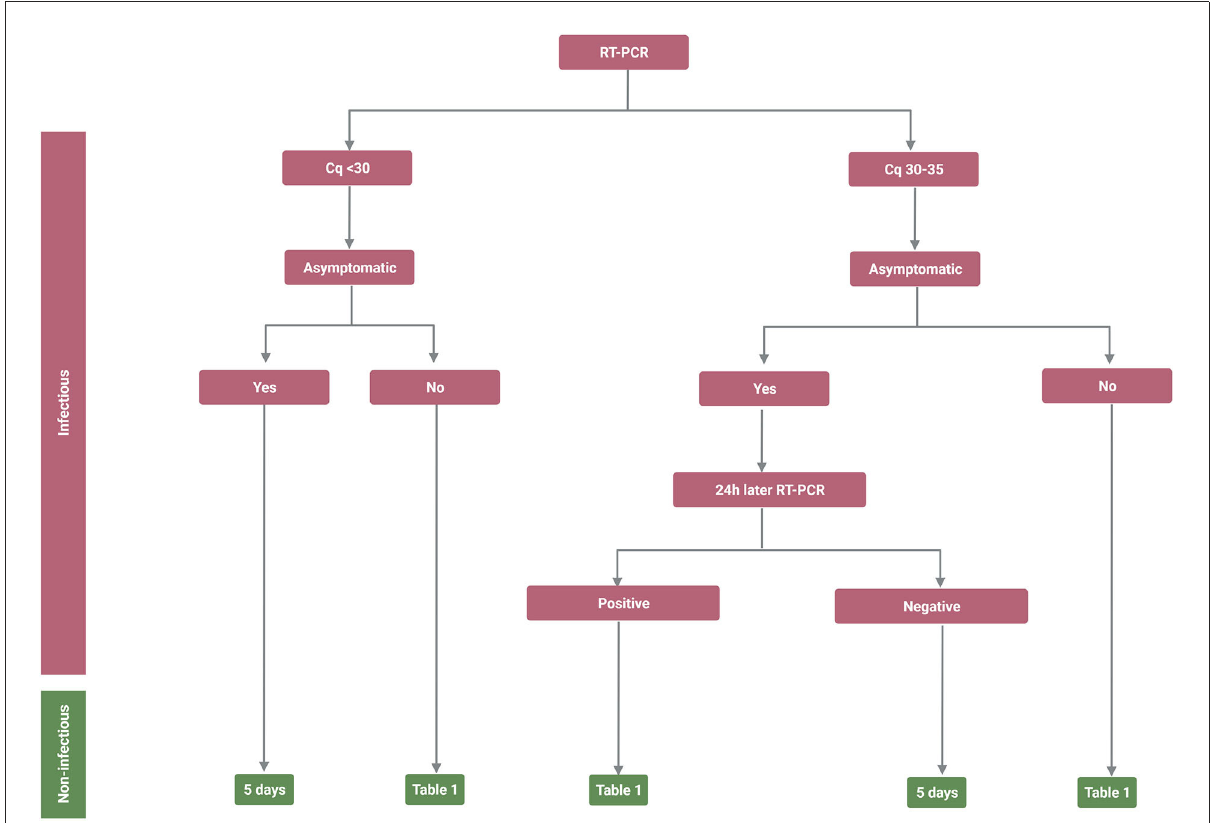
FIGURE1 Infectivity and non-infectivity of fully vaccinated, immune competent, patients infected with Severe Acute Respiratory Syndrome Coronavirus 2 (SARS-CoV-2). Flow chart depicting the suggested strategy on how to isolate SARS-CoV-2 infected individuals to minimize the likelihood of releasing infectious individuals back into society. The flow chart takes into account that it is the last symptom or reverse transcription polymerase chain reaction (RT-PCR) measurement (Cq value) that defines in what category the individual will place since patients will be in different stages of the disease when they are sampled. *It should be noted that the positive predicted value of the antigen test can vary and it may therefore be important to confirm the diagnosis with RT-PCR. Created with BioRender.com.